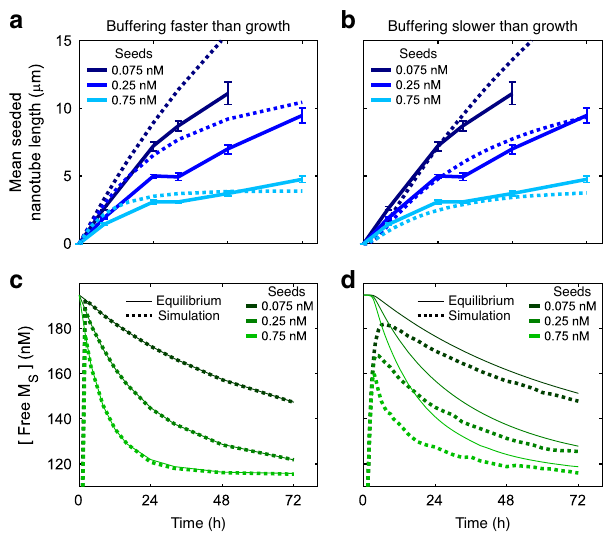
Fig. 7 Monomer buffering appears to be slower than nanotube growth for our selected concentrations of monomer buffering species. a , b Mean seeded nanotube lengths measured in experiments (solid lines) or simulations (dashed lines) during buffer-regulated growth. Error bars represent 95% con fi dence intervals from bootstrapping. c , d S monomer concentrations during simulations of buffer-regulated growth (dashed lines). Solid lines represent the theoretical equilibrium S monomer concentrations over the course of the experiments (Supplementary Note 8). Regulated growth simulations were conducted as described in Supplementary Note 9 with [ I i ] o = [ P i ] o = 5.5 µ M and [ C i ] o = 1.25 µ M for both monomer types. The forward and reverse buffering rate constants were 1 × 10 2 and 1 × 10 4 M − 1 s − 1 , respectively, for the simulations where monomer buffering was faster than growth (left panels) and 1 × 10 0 and 1 × 10 2 M − 1 s − 1 for the simulations where monomer buffering was slower than growth (right panels). See Supplementary Note 11 for additional simulation